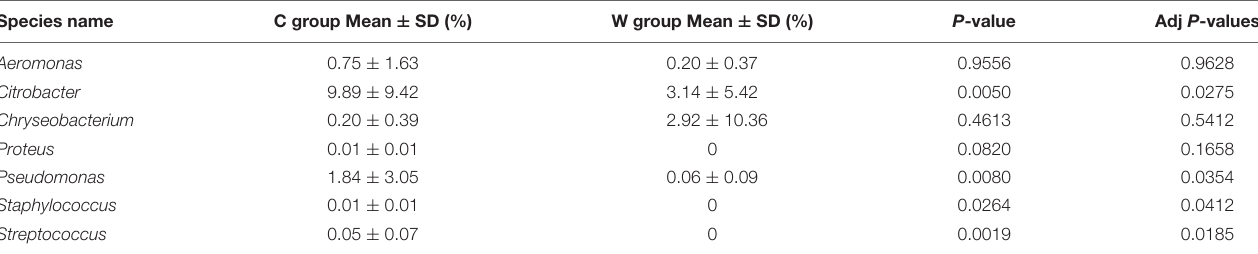
TABLE 2 | Mean relative abundances of potential opportunistic pathogens in the guts of brown frogs, as determined by the by metagenomeSeq with P -value and adj P